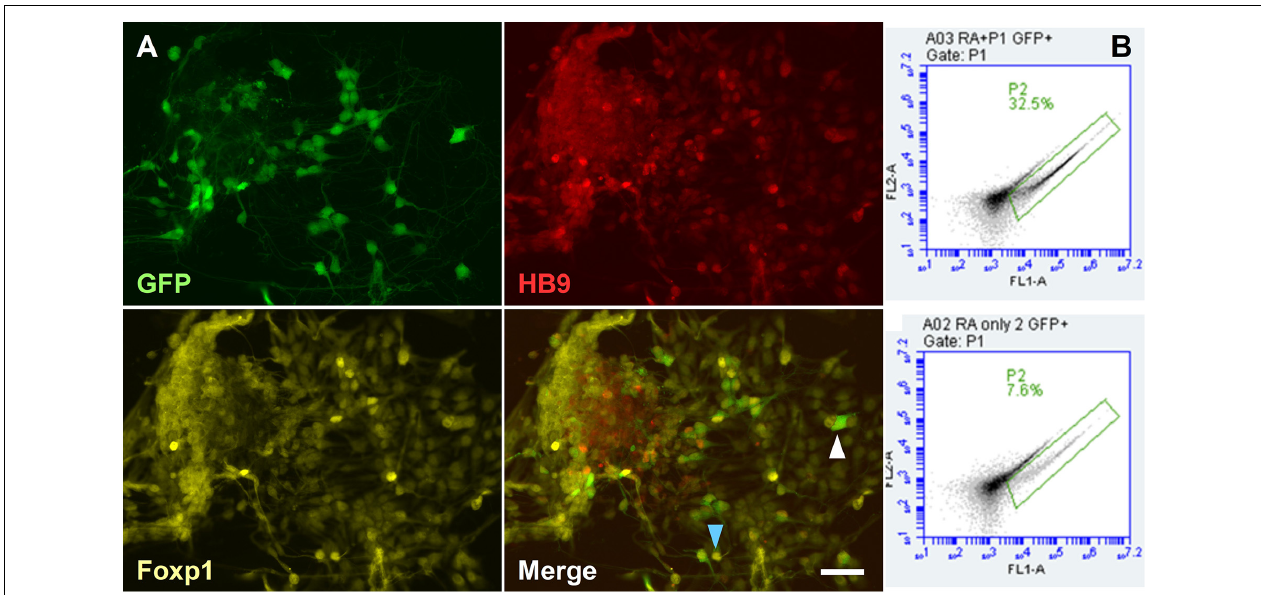
FIGURE 7 | Derivation of LMC-MN from the HGF11 transgenic cell line. (A) HGF11-derived MNs were GFP + , HB9 + , and Foxp1 + . GFP + cells were usually Foxp1 + and HB9 + (blue arrowhead), with a few exceptions (white arrowhead). n = 3 independent experiments. Scale Bar: 20 µ m. (B) Quantification of GFP + cells via flow cytometry. HGF11 ESCs differentiated with RA and purmorphamine (top panel) or just RA (bottom panel). n = 3 independent experiments, 10,000 events per